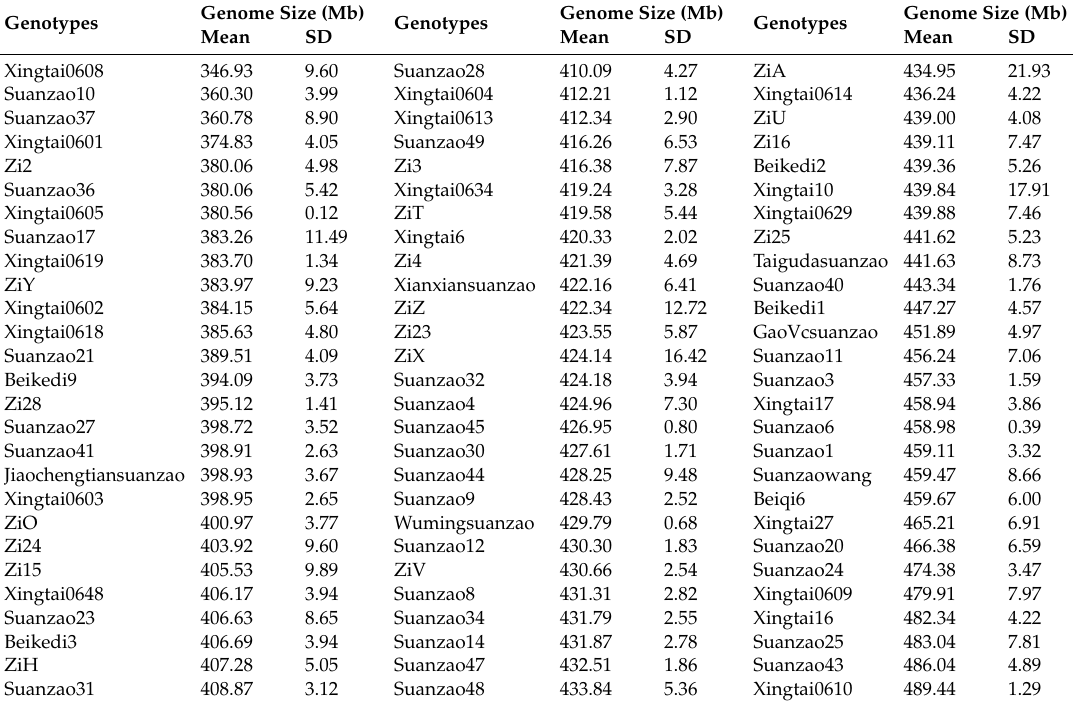
Table 2. The genome sizes of the 81 genotypes of sour